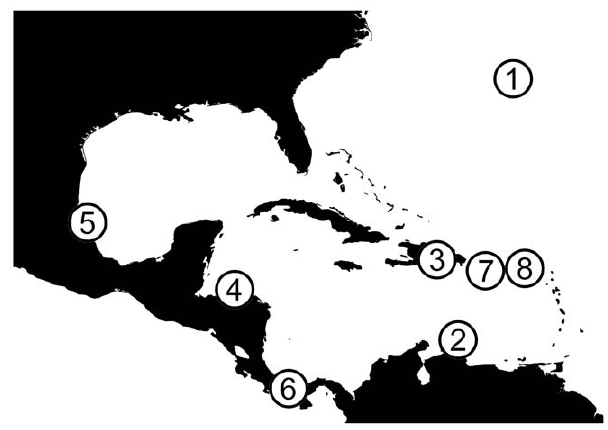
Figure 1. Map of sampling locations for AFLP analysis of Hypoplectrus morphotypes. 1=Bermuda, 2=Curac¸ao, 3=Dominican Republic, 4=Honduras, 5=Mexico, 6=Panama, 7=Puerto Rico, 8=U.S. Virgin Islands.